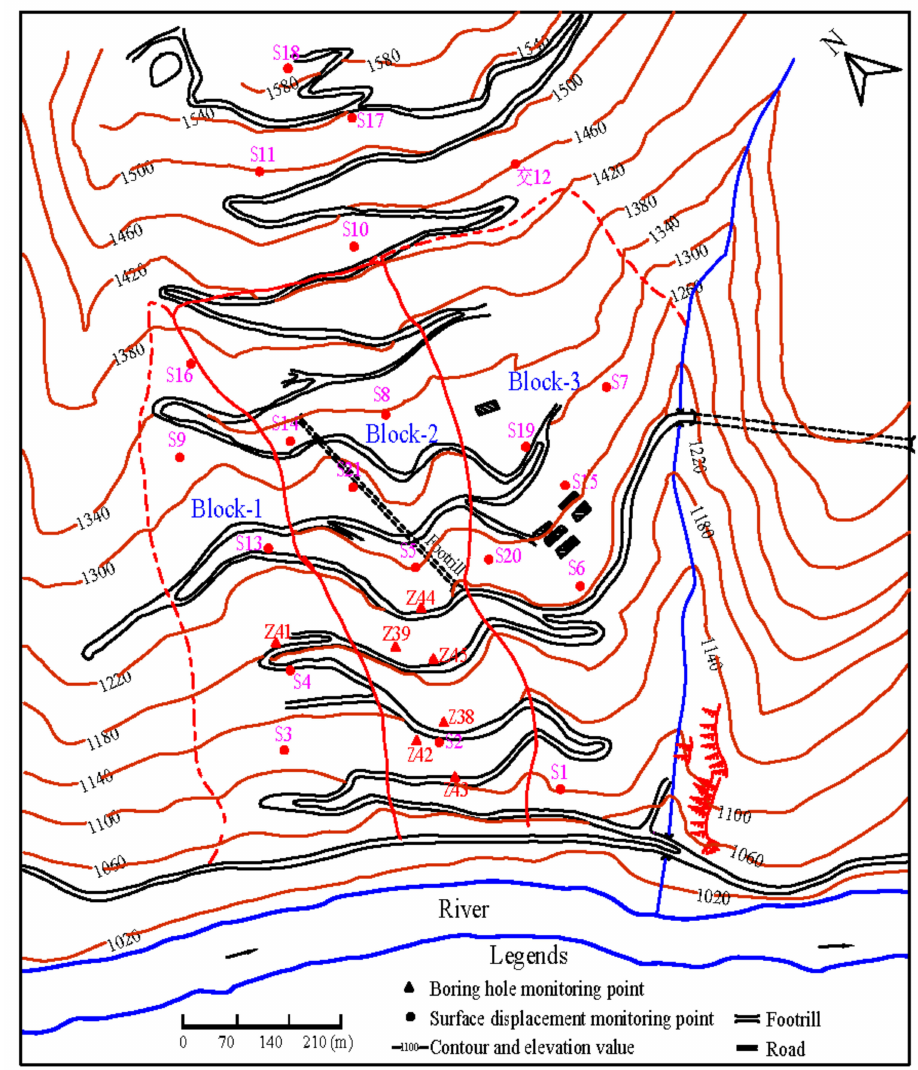
Figure 3. Plan of the landslide and its monitoring